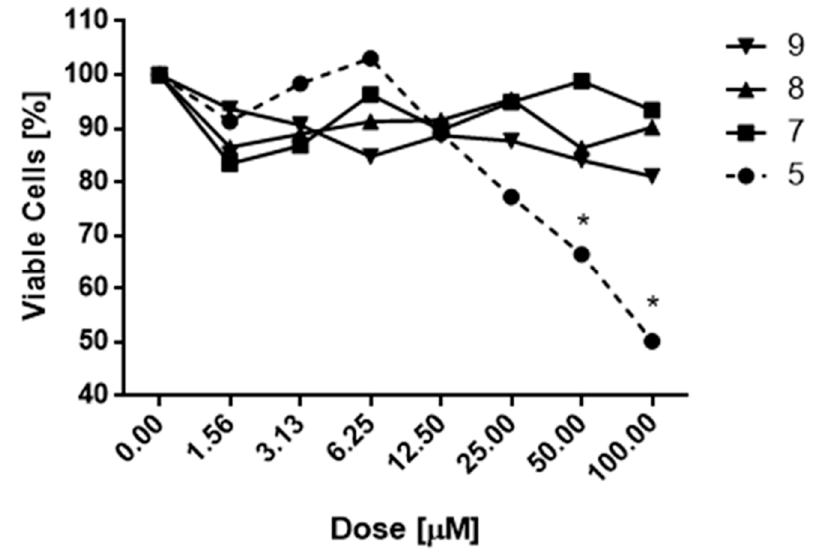
Figure 2. Effect of the four newly synthesized carbanucleoside analogues ( 5 , 7 – 9 ) on the viability of Huh7.5 SG cells.